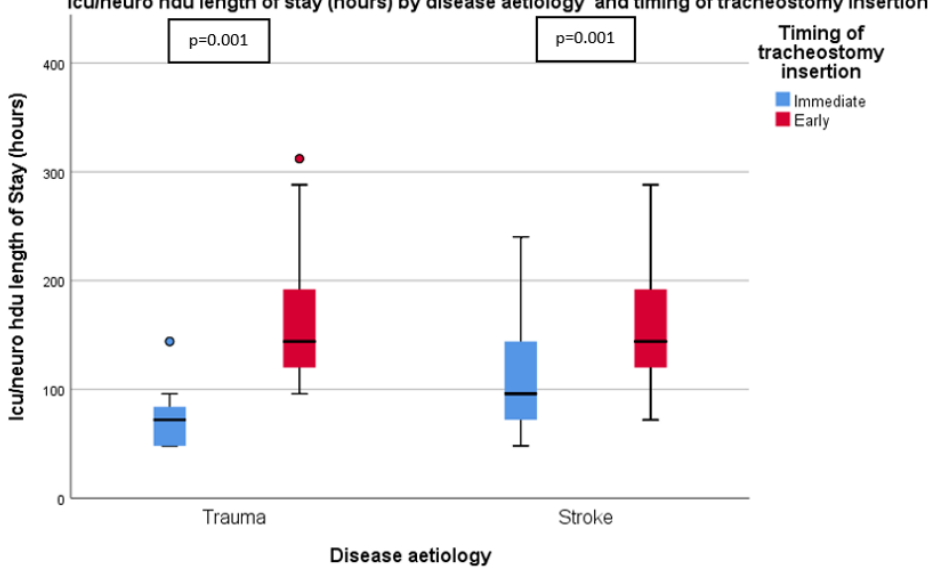
Figure 6. ICU/Neuro HDU length of stay (hours) by disease aetiology and timing of tracheostomy insertion.